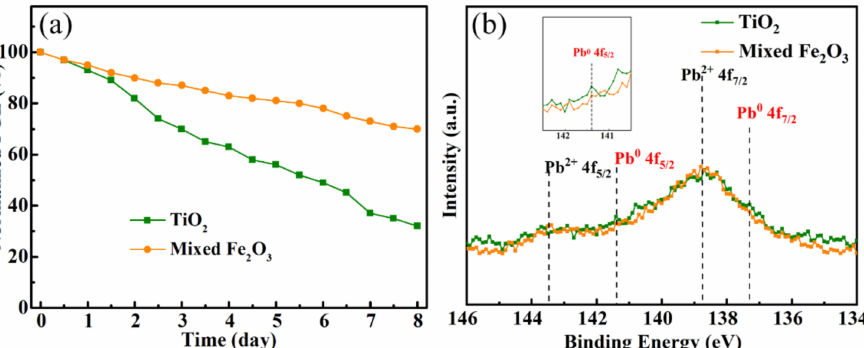
Figure 4. ( a ) Long-time stability test under AM 1.5 G of controlled TiO 2 and mixed-SnO 2- ETL-based perovskite solar cells. ( b ) XPS spectra depicting Pb 4f 5/2 and Pb 4f 7/2 peaks of controlled TiO 2 and mixed-SnO 2- ETL-based perovskite solar cell, which were tested for long-time stability for 7